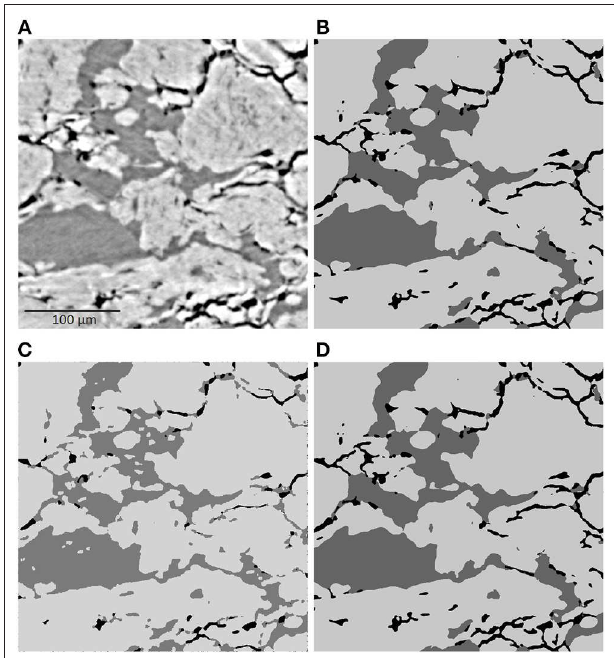
FIGURE 1 | 2D slice of a cutout of the grayscale image (A) and the corresponding results of the three different trinarization algorithms, namely the trinarization by statistical learning (B) , by the aid of a watershed algorithm (C) , and by a hybrid approach (D) . In the trinarized images (B–D) , black, dark gray and bright gray indicate the pore space, API and MCC,